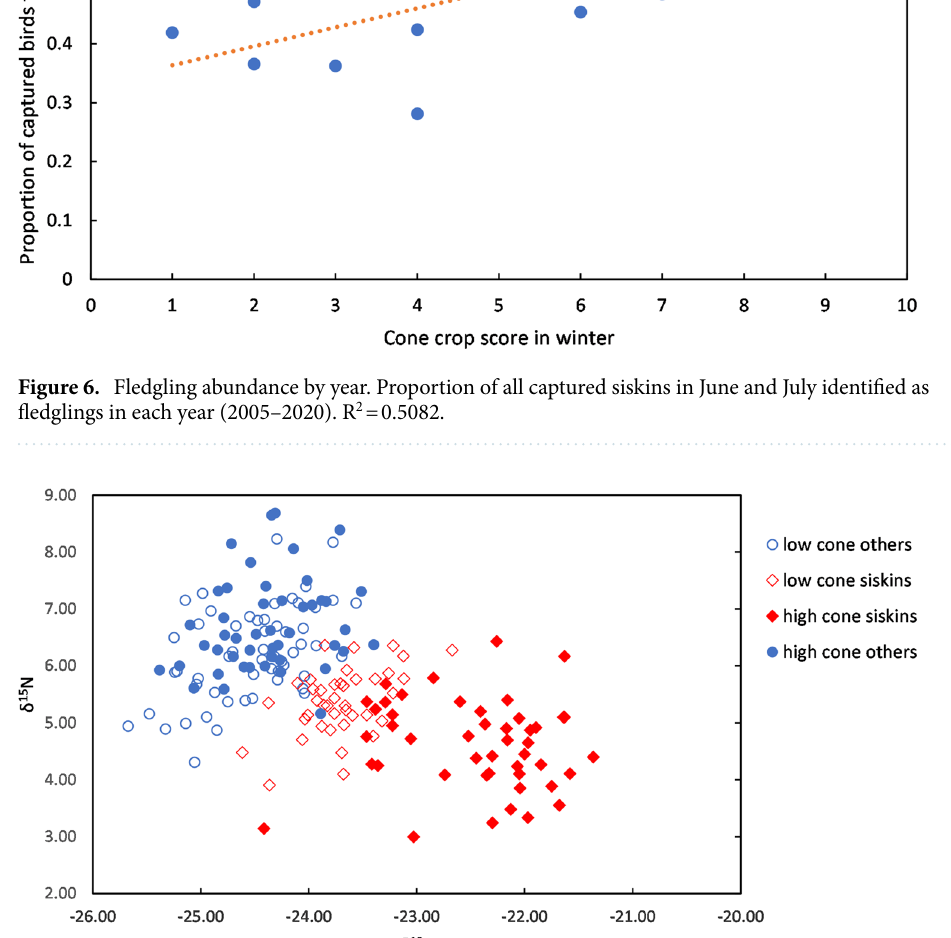
Adult abundance. The mean number of adult siskins caught per day during the breeding season showed a slight sign of increase from 2005 to 2020, from about 30 to about 45 birds per catch (Table 1). As such, analysis of the impact of cone crop on adult catch rate was performed with year as a covariate, in order to control its effect. The mean number of adult siskins caught per day was significantly lower in years with higher cone crops (ANOVA linear regression, with “year” as an additive covariable: F = 5.6912, n = 16, p = 0.03296). Juvenile weight and size. Monthly mean weight of newly fledged juvenile siskins tended to increase over the course of the breeding season (ANOVA linear regression, additive model containing cone score and month (May–July), excluding months with < 10 captures: F = 17.3465, n = 37, p = 7.104 × 10 –6 ), as did monthly mean juvenile wing length, although the latter relationship is very weak (ANOVA linear regression, additive model containing cone score and month (May–July), excluding months with < 10 captures: F = 3.3847, n = 37, p = 0.04602) and data from a wider range of months suggest that this trend may not be meaningful (Supplemen- tary Table 1). Cone score had no significant impact on either of these measurements (ANOVA linear regression, additive model containing cone score and month (May–July), excluding months with < 10 captures: F = 0.5605, n = 37, p = 0.4594) and (ANOVA linear regression, additive model containing cone score and month (May–July), excluding months with < 10 captures: F = 0.0373, n = 37, p = 0.84801) respectively.